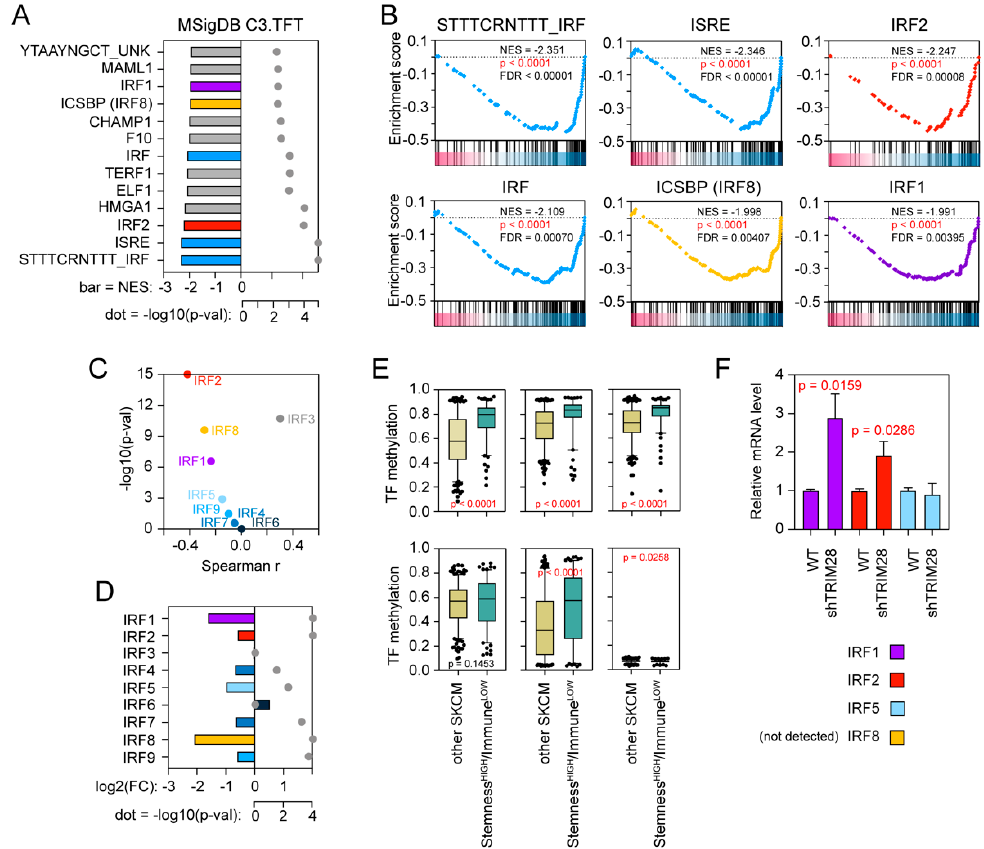
Figure 6. Significant attenuation of the interferon signaling by TRIM28-mediated epigenetic silencing of the IRF transcription factor family. ( A ) The GSEA of all significantly differentially expressed genes in the TRIM28 HIGH melanoma patients revealed significant depletion of 13 transcription factor genesets in the TRIM28 HIGH phenotype. As a reference, MSigDB C3 TFT v.7.1 collection was used. Only datasets with a nominal p -value < 0.01 and FDR < 1% are shown. ( B ) Enrichment plots for targets of IRF family members were significantly downregulated in the TRIM28 HIGH melanoma phenotype. Statistical significance and NES values are shown. ( C ) Spearman correlation of the TRIM28 expression with the level of IRF family members in the SKCM TCGA data. ( D ) The relative expression of IRF family members in Stemness HIGH /Immune LOW cohort (when compared to other SKCM patients). Bar—fold change (log2 normalized); gray dot—statistical significance ( − log10(p-val)). ( E ) Tukey box plots of the methylation of IRF1, IRF2, IRF5, IRF7, IRF8, and IRF9 in the SKCM TCGA patients with discriminated Stemness HIGH /Immune LOW cohort. Statistical significance is denoted on the graphs. ( F ) The relative expression of IRF family members in SK-MEL28 melanoma cell line with shRNA-downregulated expression of TRIM28. Specific primers were used for IRF1, IRF2, IRF5, and IRF8 transcripts’ detection. IRF8 transcript is undetectable in SK-MEL28 cells cultured in standard conditions. n = 3 biological replicates, bar—the mean gene expression, whiskers—SD. The statistical significance is denoted in the graph (Student’s t- test).